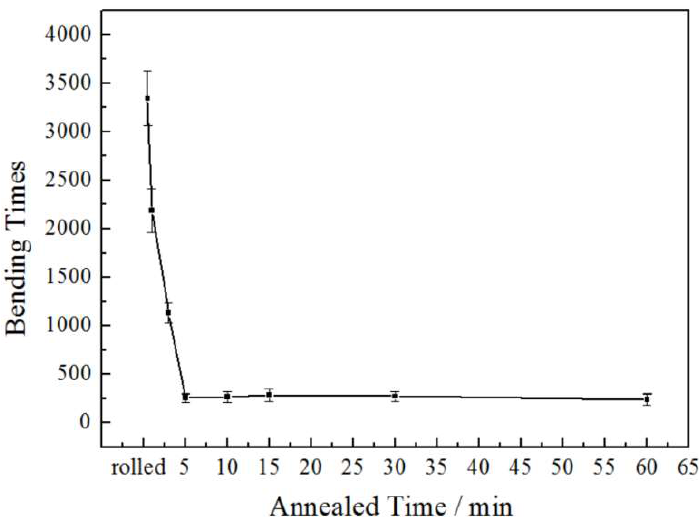
Figure 11. Bending resistance properties of the rolled and annealed copper foil.